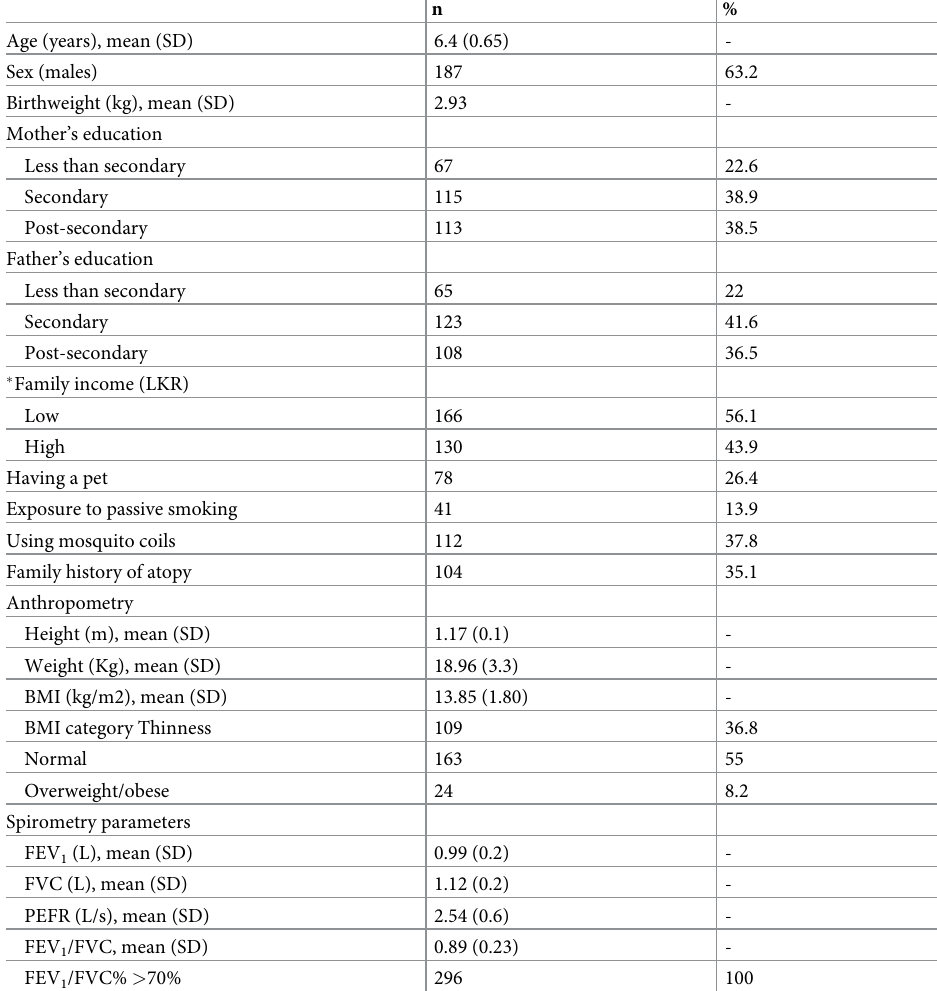
with ATS standards. There were 15 incomplete questionnaires. The response rate was 83%. Basic characteristics of the sample, including anthropometry and spirometry parameters, are shown in Table 1. The participants’ mean age (SD) was 6.4 (0.65) years. Most were males (63.2%). Almost half (44%) were in the higher income category. More than two-thirds of the parents had either secondary or post-secondary education. Most children had normal BMI (55%), while one-third had thinness (37%). Weak but significant positive correlations were found between BMI and FVC (r = 0.22, p < 0.001). A similar association was noted with FEV (r = 0.23, p < 0.001) and PEFR (r = 0.15, 1 p = 0.02). FEV /FVC ratio did not show a significant association with BMI (p = 0.19). Lung 1 function parameters were positively correlated with age FVC (r = 0.31, p < 0.001), FEV 1 (r = 0.33, p < 0.001), PEFR (r = 0.30, p < 0.001), and FEV /FVC ratio (r = 0.23, p < 0.001). As 1 determined by one-way ANOVA, there was a statistically significant difference in FVC (p- Table 1. Basic characteristics of the